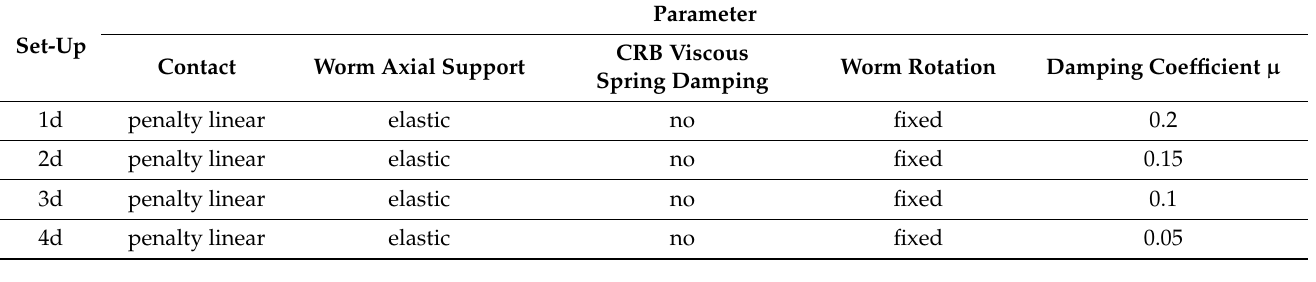
Table 4. Damped contact simulation set-up.